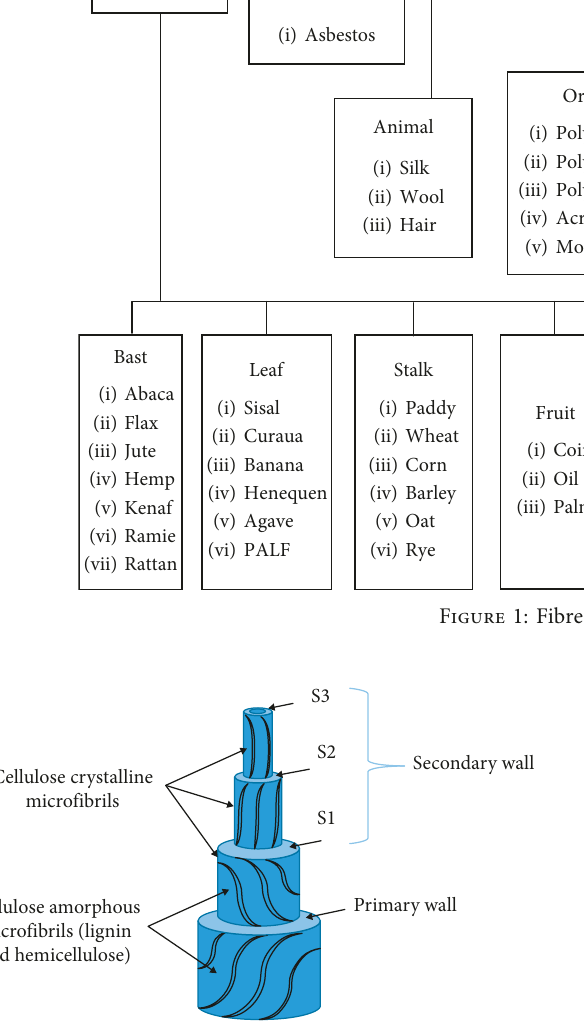
Figure 2: Schematic representation of PF structure (source: